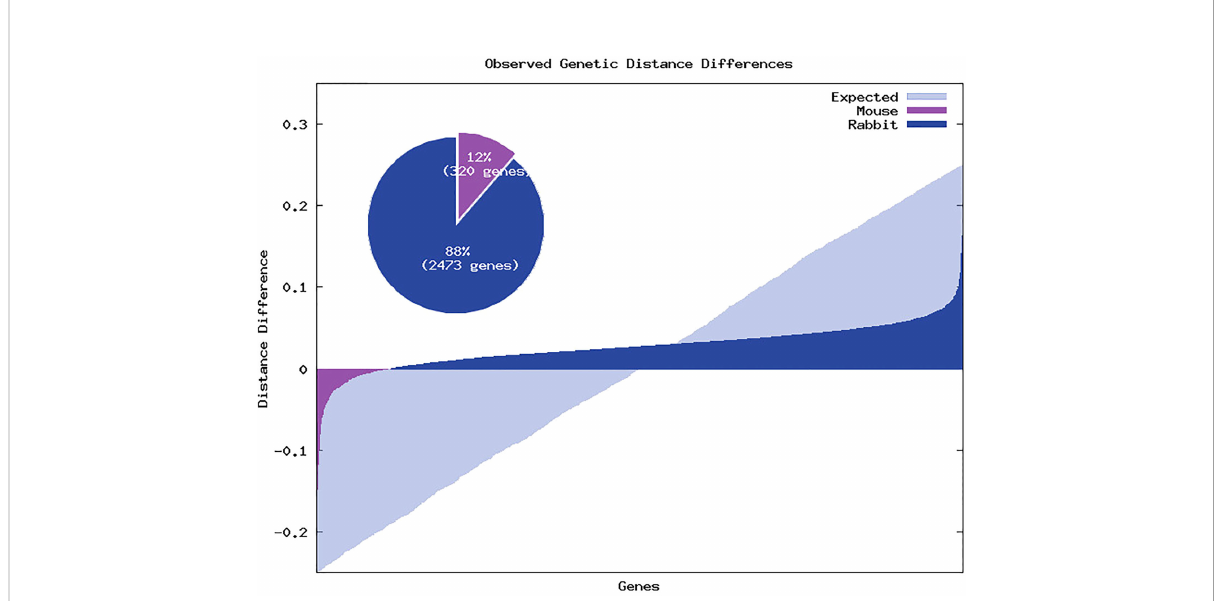
FIGURE 4 Genetic distance differences between rabbit and human and mouse and human. Positive values represent genes in which the genetic distances between mouse and human is greater than the genetic distances between rabbit and human. Light blue regions represent the expected relative gene distances between the similarities between rabbit and human and mouse and human. Dark blue regions represent the relative distances in which gene similarity between rabbit and human is higher than between mouse and human. Violet regions represent the relative distances in which gene similarity between rabbit and human is lower than between mouse and human. The pie chart represents the percentage of genes for which the genetic distances between rabbit and human are lower than mouse and human (in dark blue) and for which the genetic distances between mouse and human are lower than rabbit and human (in